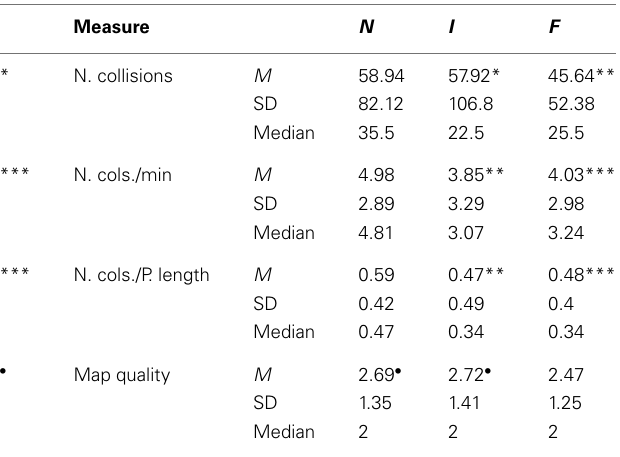
Table 2 | Non-subject-normalized DV results for different interface treatments in study #2 .